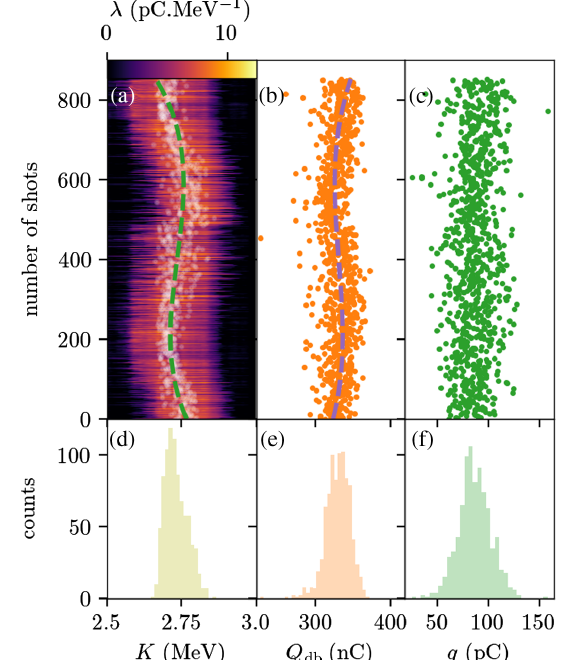
FIG. 5. Waterfall plot of measured energy spectra density λ over 853 shots (a) with associated drive-beam charge transmitted through the PETS (b), and corresponding bunch charge photo- emitted from the XRF gun (c). Plots (d) – (f) are the associated histograms. The dashed trace in (a) is a spline interpolation of the slow drift which is superimposed as a dashed curve in (b) after applying an affine